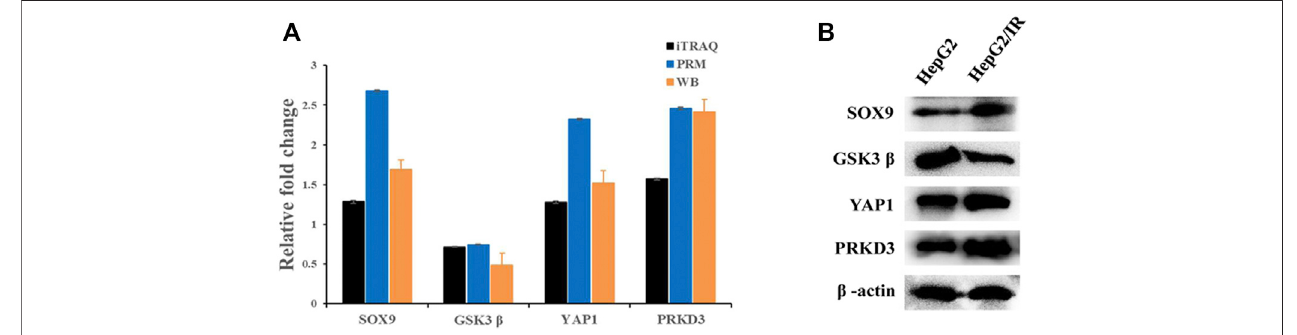
FIGURE7| Thecomparison ofproteinexpressiondetected byiTRAQandPRM (A) andWesternblot (B) .RelativefoldchangemeanstheratioofInsulinresistance group and Control group.